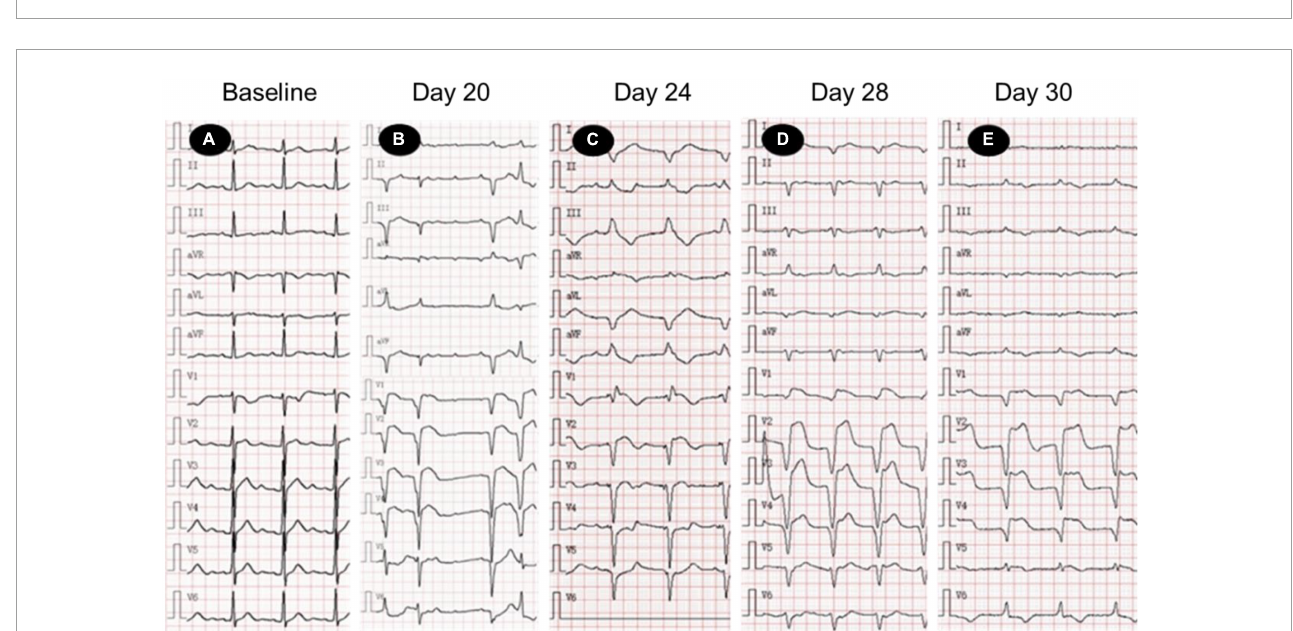
FIGURE3 Electrocardiogram (ECG) changes in patients with acute myocarditis before and after immune checkpoint inhibitors (ICI) treatment. (A) Normal ECG; (B) sinus tachycardia, 3-degree atrioventricular block, frequent ventricular premature beats; (C) ventricular pacing rhythm (VVI, heart rate 70 times/min), ST segment elevation of anterior septum; (D,E) junctional tachycardia, ST segment elevation of anterior septum. ECG, electrocardiogram.